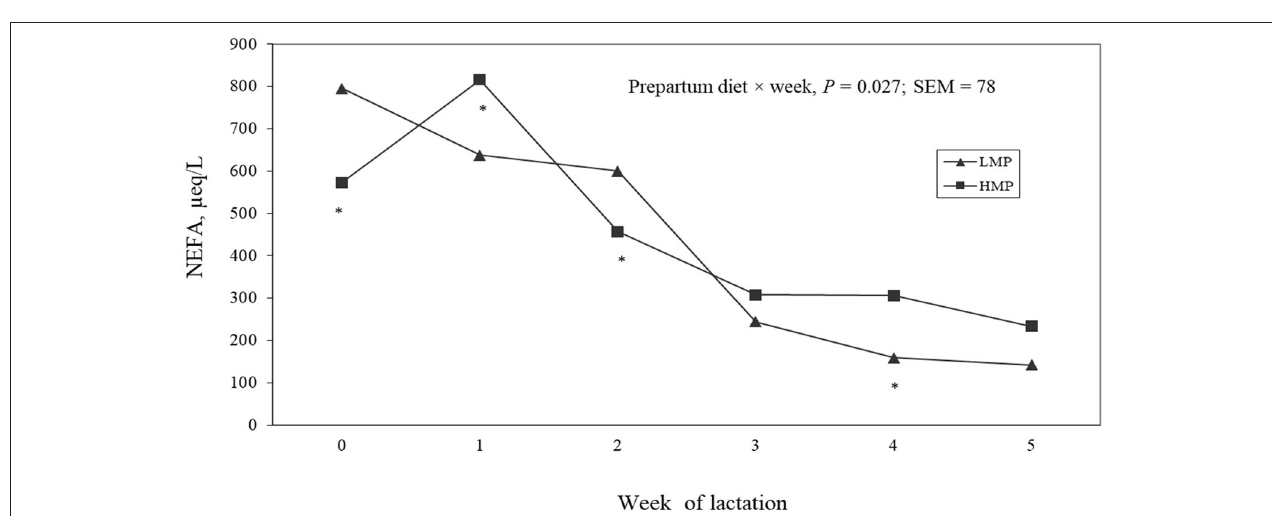
FIGURE 2 | Least squares means for postpartum concentrations of non-esterified fatty acids (NEFAs) in plasma from cows fed diets with low metabolizable protein (LMP) or high metabolizable protein (HMP) during the prepartum period.